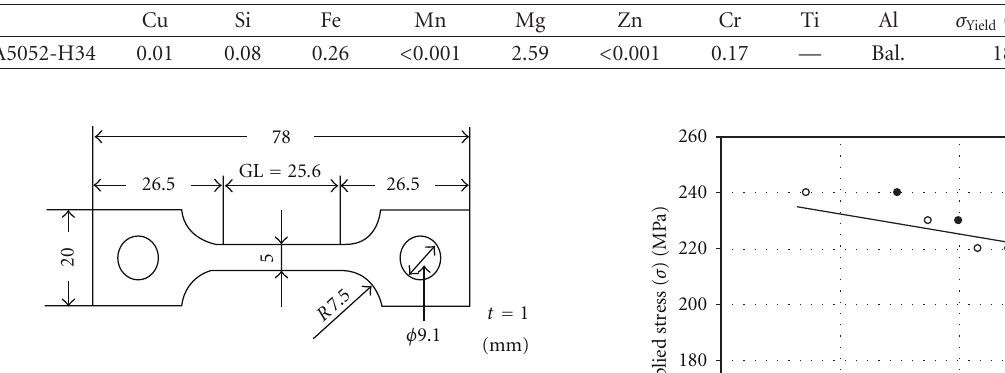
Figure 1: Geometry of the specimens (dimensions in mm).